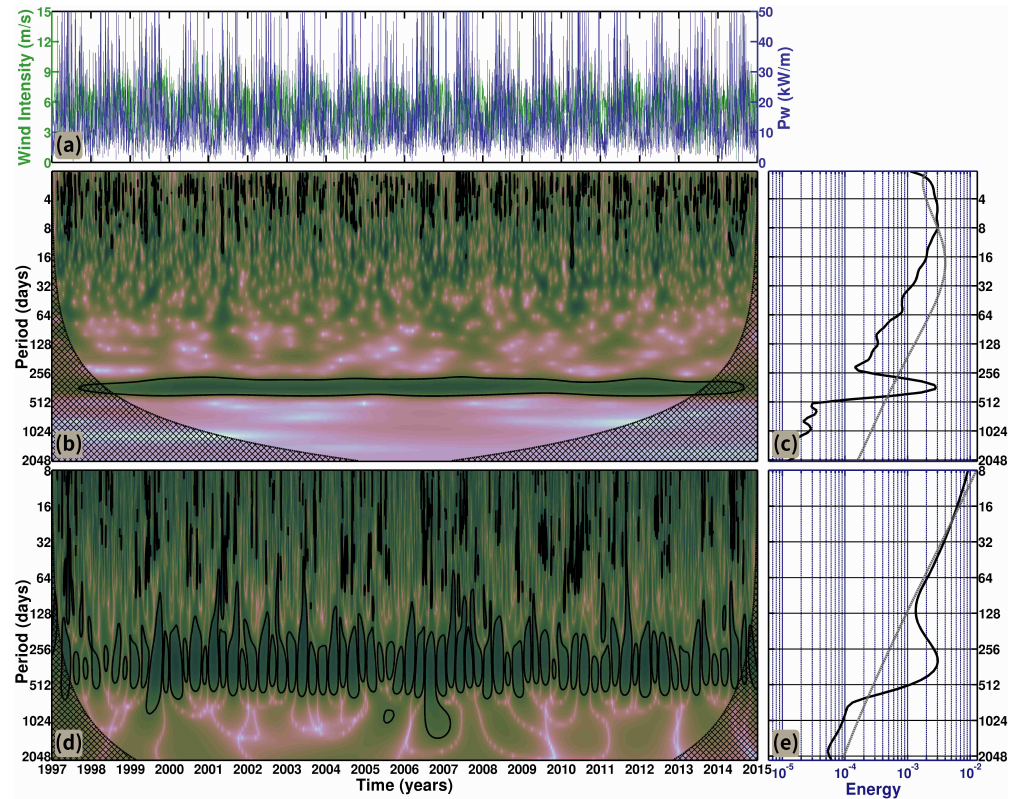
Figure 13. ( a ) Time series of wind intensity (blue) and P w (green) used for the cross-wavelet analysis. ( b ) Local Morlet wavelet power spectrum. Thick contour lines enclose regions of greater than 95% confidence for a red noise process with a lag1 coefficient of 0.7. Cross-hatched regions indicate the cone of influence where edge effects become important. ( c ) Global Morlet power spectrum of the time series and the dotted line indicate the 95% confidence level. ( d ) Mexican Hat local wavelet power spectrum. Thick contour lines enclose regions of greater than 95% confidence for a red noise process with a lag1 coefficient of 0.1. Cross-hatched regions indicate the cone of influence where edge effects become important. ( e ) Global Mexican Hat power spectrum of the time series and the dotted line indicates the 95% confidence level on the coastal zone of Farol Island. Cube Helix color scheme developed by Green